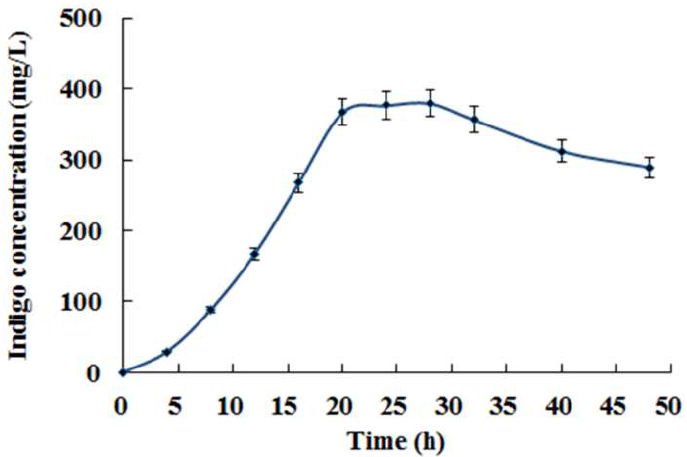
Figure 3. Indigo production from 1.0 mg/mL of tryptophan in E. coli AB fermentation.